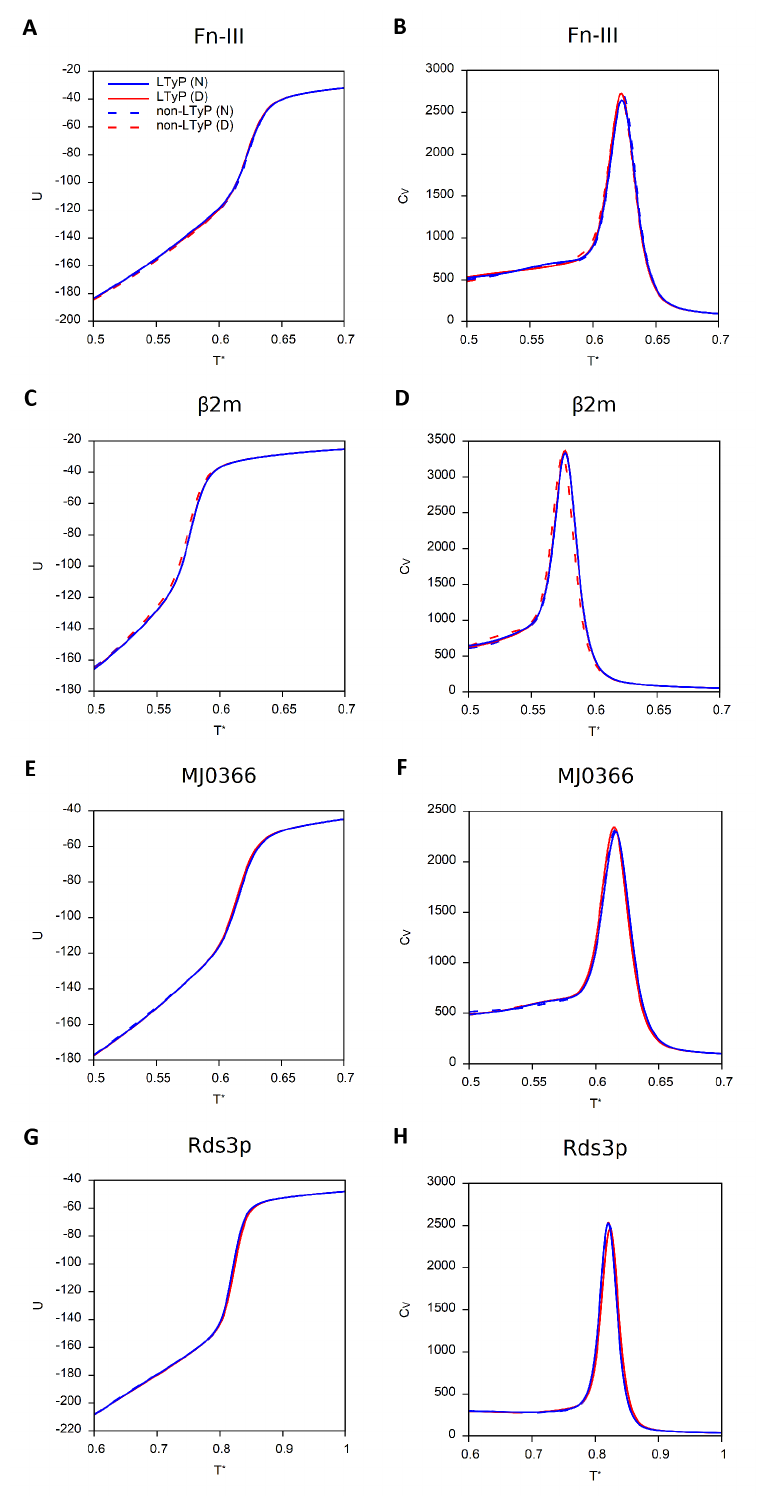
Figure 2. Internal energy, U , and heat capacity, C V , as functions of the reduced temperature, T ∗ (see Section 4). Simulations starting from the native conformation (N) are colored blue, and those starting from a denatured conformation (D) are colored red. Continuous lines correspond to LTyP simulations and dashed lines to non-LTyP simulations. ( A , B ) Fn-III (PDB id: 1TEN). ( C , D ) β 2m (PDB id: 1BMG). ( E , F ) MJ0366 (PDB id: 2EFV). ( G , H ) Rds3p (PDB id: